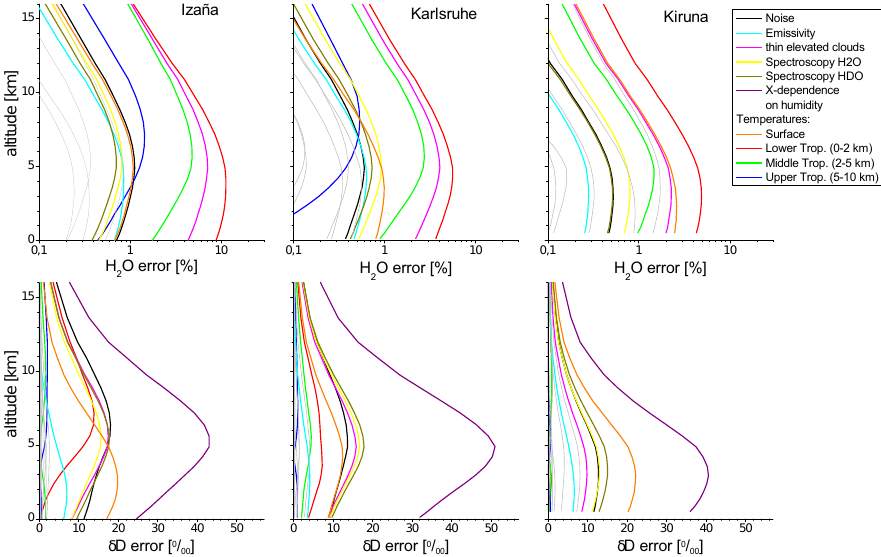
Figure 5. Error estimation for humidity and the isotopologue at all measurement sites. The estimated and used magnitudes can be found in Table 2. Minor error sources are depicted as grey lines and are included in the total error.